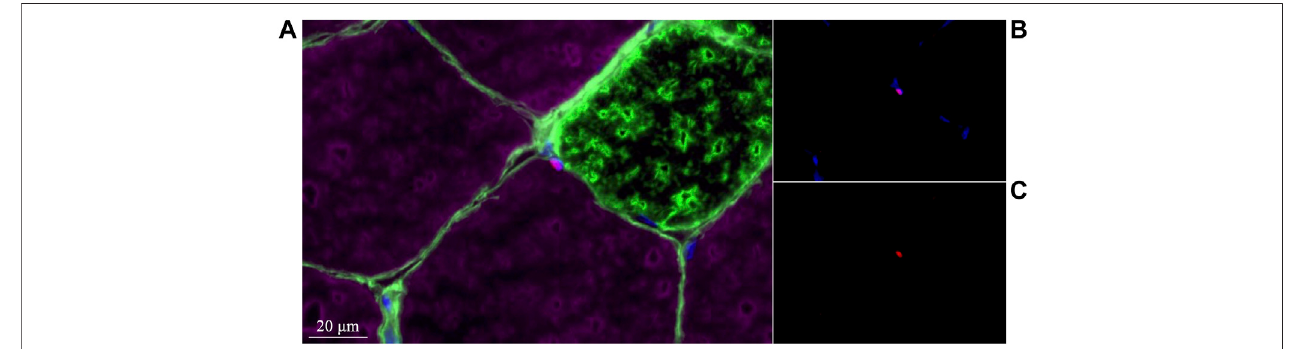
FIGURE 2 | Representative image of a type II-associated satellite cell in the present study. (A) MHCI (green) +Laminin (green) +MHCII (purple) +Pax7 (red) +DAPI (blue). (B) Pax7 (red) +DAPI (blue). (C) Pax7 (red).